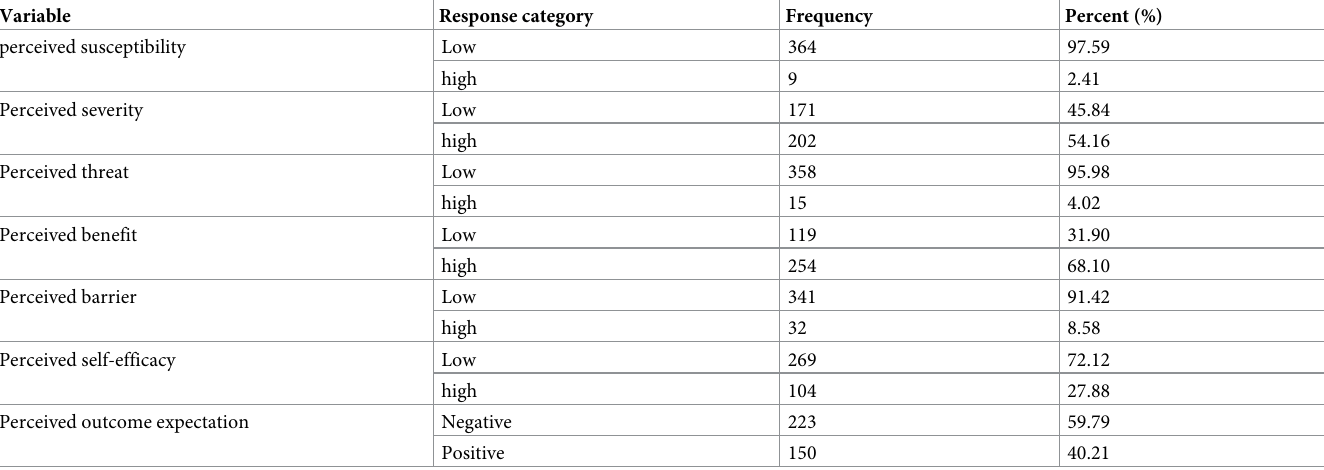
Table 5. Perception of young adult women towards breast cancer and BSE Gurage